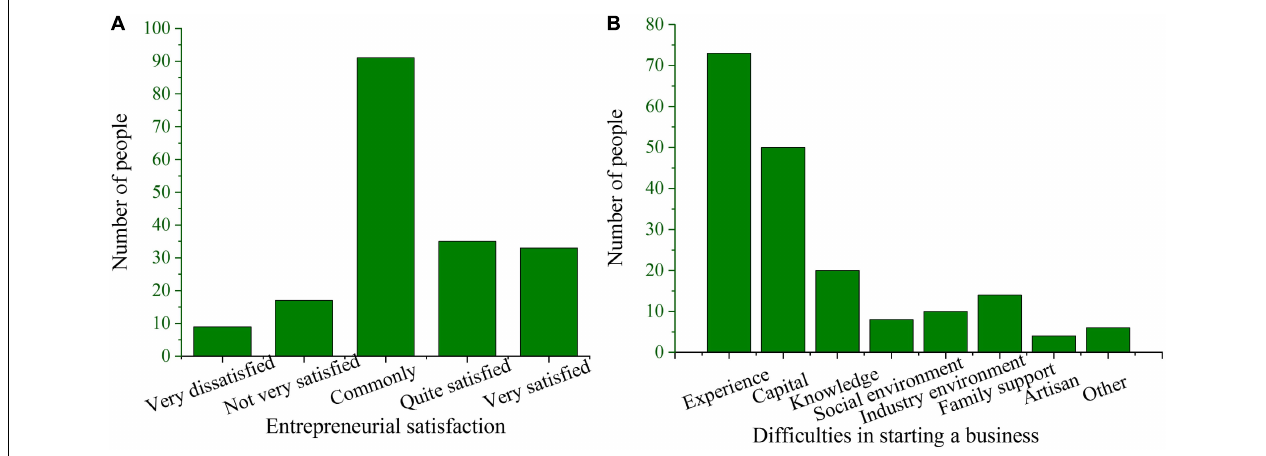
FIGURE 5 | Entrepreneurial satisfaction and main difficulties of college students. (A) Entrepreneurial satisfaction and (B) difficulties in starting a business.